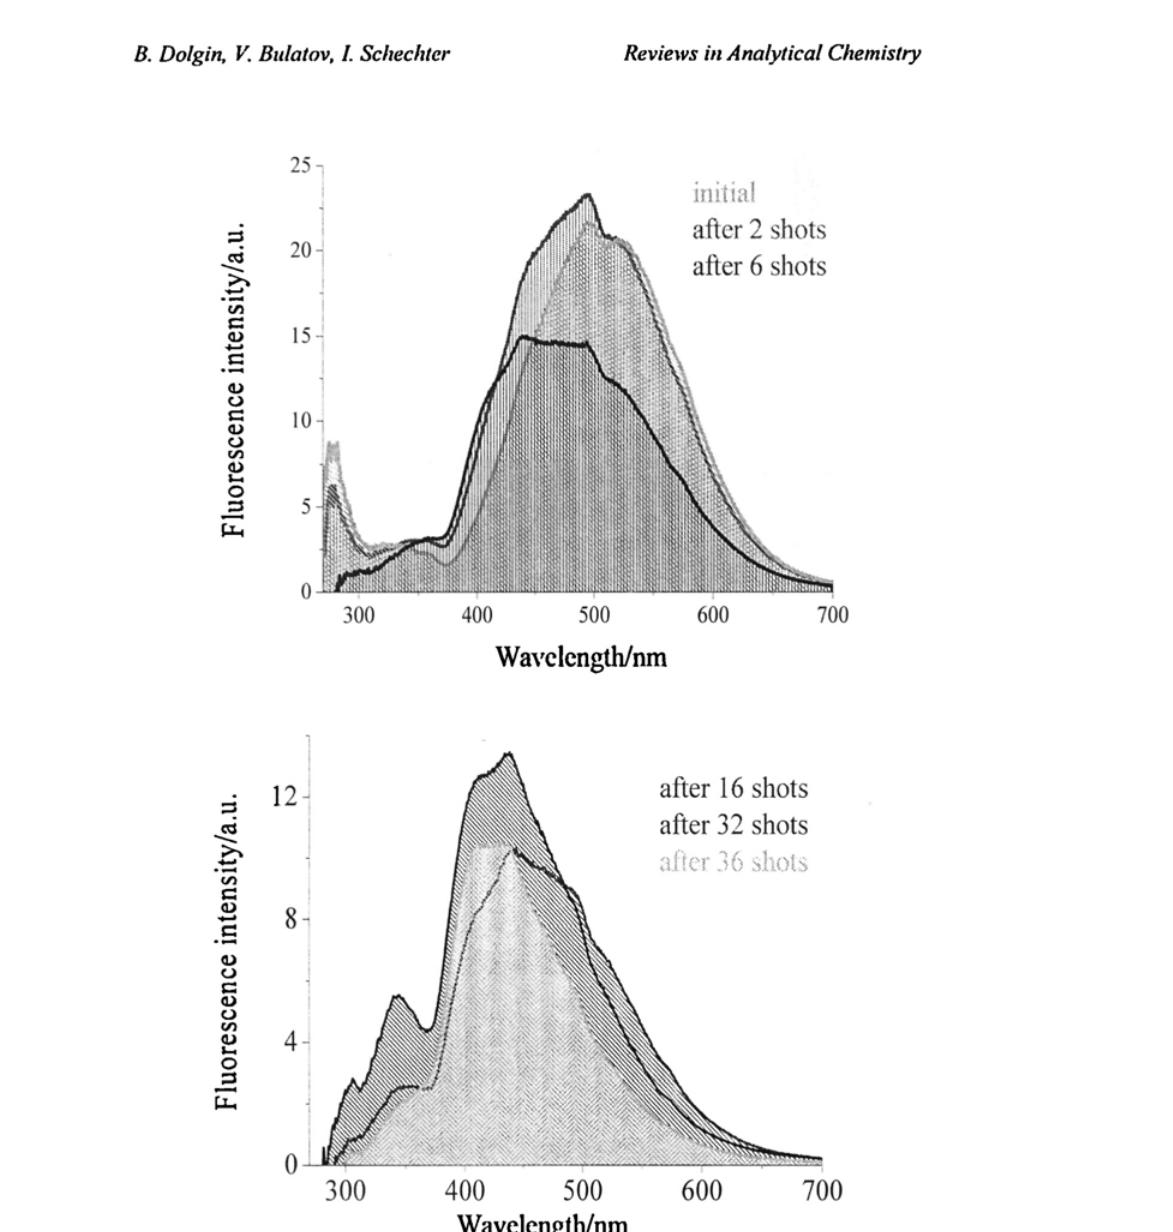
Fig. 37: Layer-resolved synchronous fluorescence of artificially aged parchment